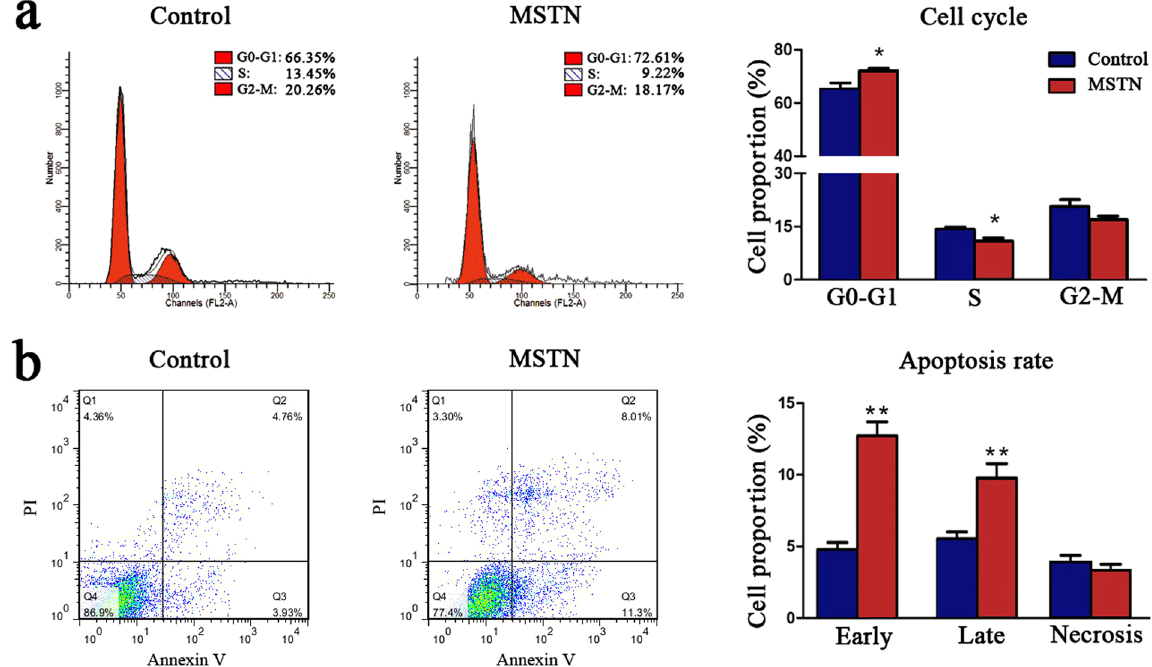
Figure 6. MSTN influenced cell cycles and apoptosis of adipocytes. Subcutaneous pre-adipocytes were treated with 50 ng/ml MSTN for 2 days and then harvested for further detection. ( a ) The effects of MSTN on the cell cycles of pre-adipocytes. Cells were stained with PI, then the cell cycles were detected by flow cytometry (left) and subsequently displayed as column charts after quantification (right), n = 3 per group. ( b ) The effects of MSTN on the apoptosis of pre-adipocytes. Cells were stained with PI and Annexin V, then the apoptosis rate was detected by flow cytometry (left) and displayed as column charts after quantification (right). n = 3 per group, * P < 0.05; ** P <